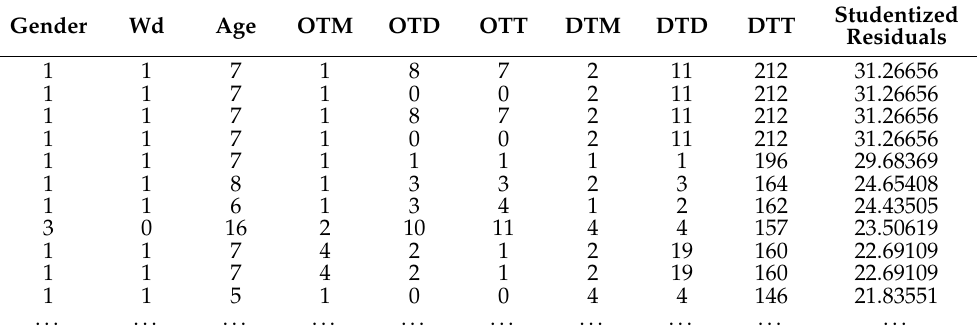
Table 5. Identification of abnormal values based on the variables of destination travel distance and time (May